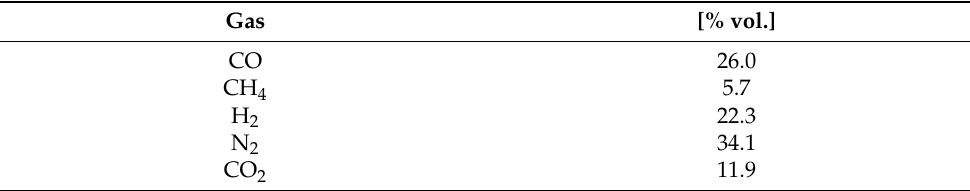
Table 1. Representative composition of a syngas on a dry